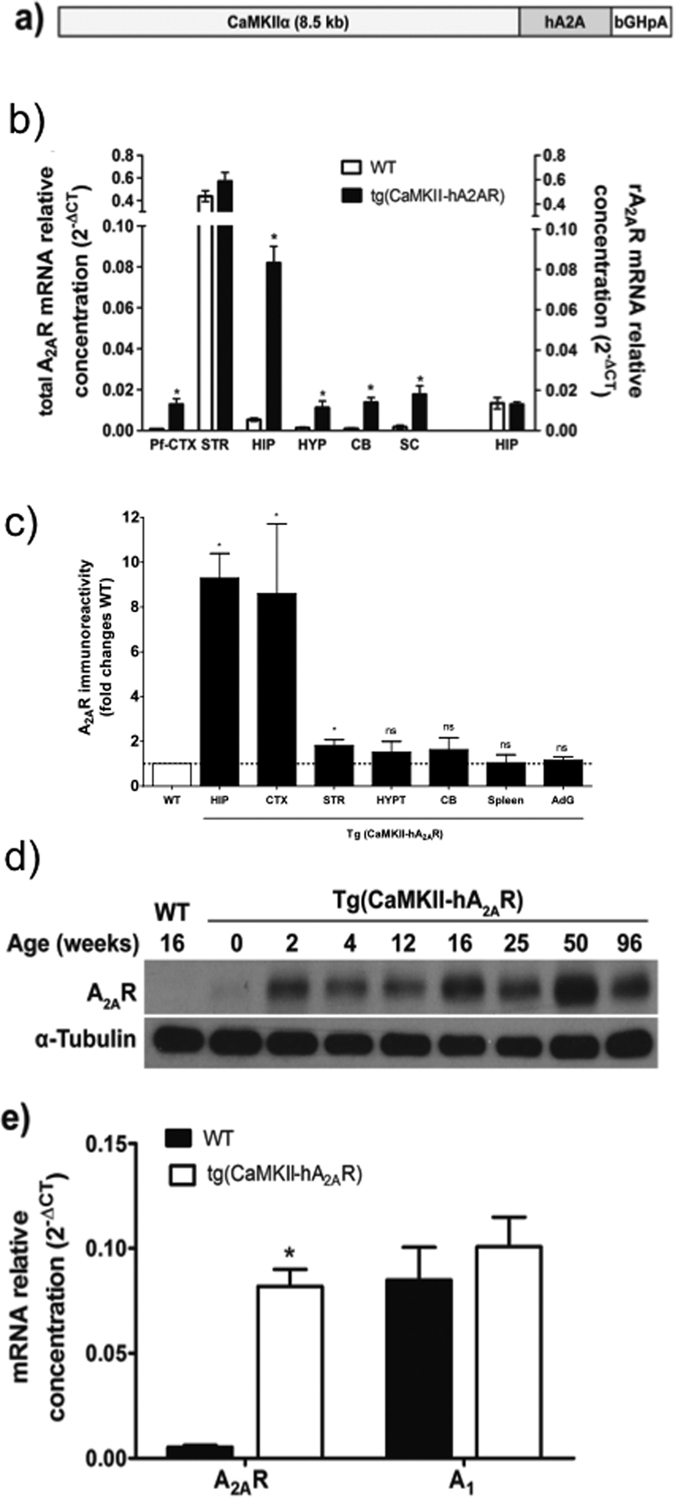
Tg(CaMKII-hA2AR) rats overexpress hA2AR in forebrain areas.(a) Construct used to generate Tg(CaMKII-hA2AR) rats. (b,c) Animals present an overexpression of total A2AR in the forebrain confirmed by qPCR and Western blotting. The endogenous (right axis) rA2AR mRNA levels were not modified in the hippocampus as assessed with specific rat A2Aprimers. (d) A2AR protein levels increase from 2 weeks old onwards in the hippocampus and (e) no changes were detected in adenosine A1R mRNA levels for 12–14 weeks old animals. Results were analysed using unpaired Student’s t-test for each gene/brain area, *P < 0.05 compared to WT.